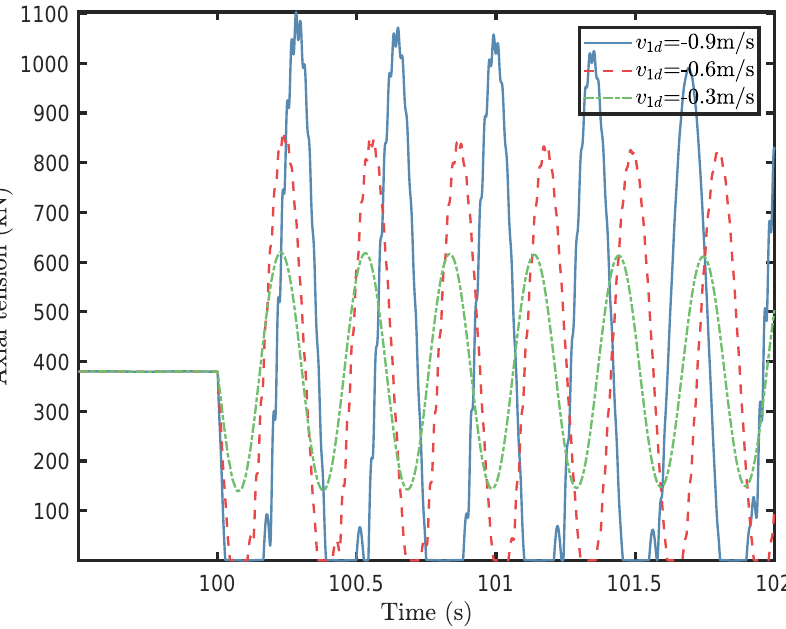
Figure 4. The lift wire tension history of a suspended blade with constant lowering